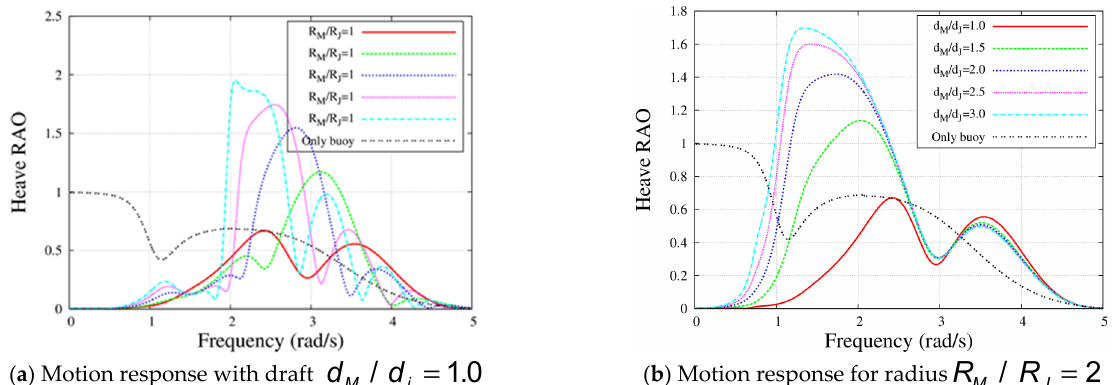
Figure 9. The motion response of the MJWEC for different radius ratios and draft ratios..